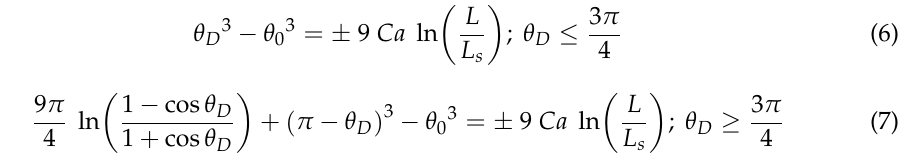
Table 1. Summary of alternative forms of hydrodynamics theory in experimental, theoretical, and numerical studies.